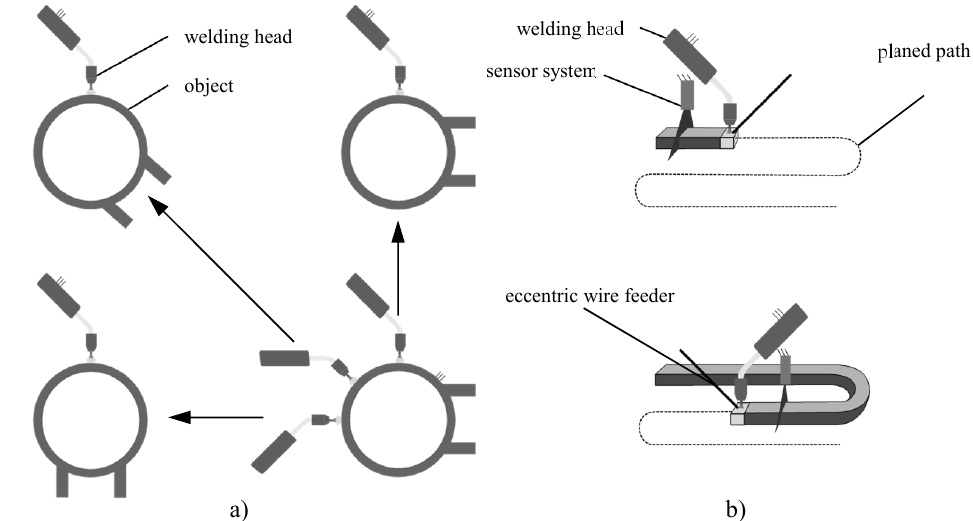
Figure 2. Object-manipulation showing advantages through: ( a ) downhand welding position; and ( b ) fixing of the periphery.